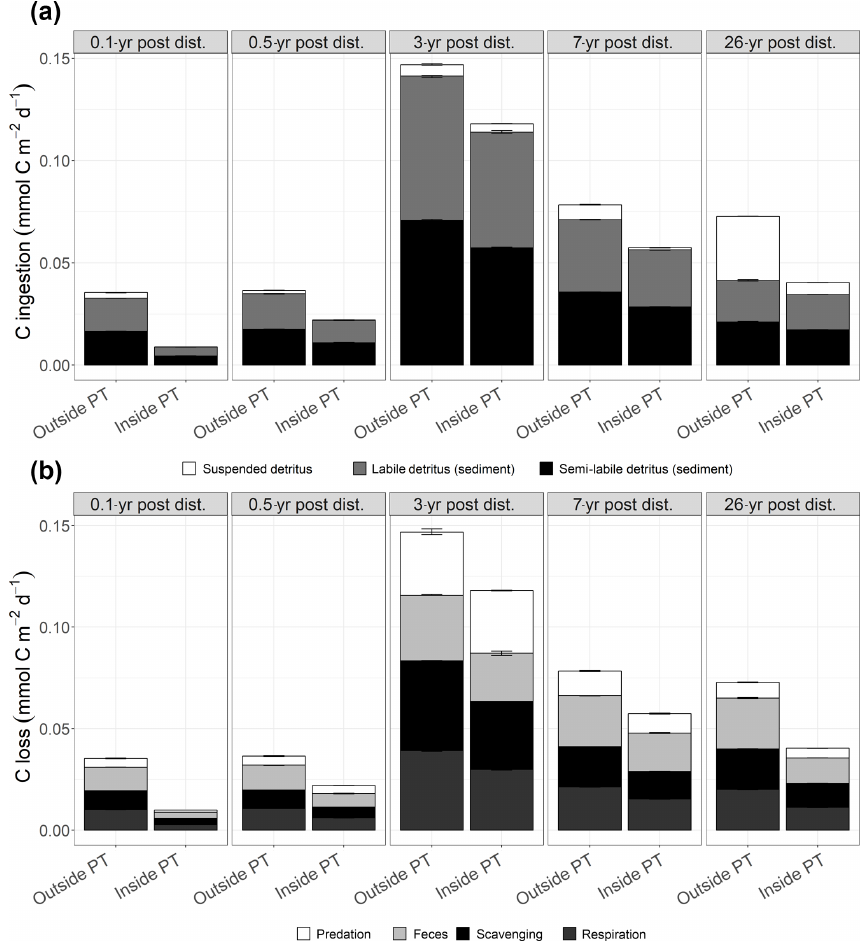
Figure 5. (a) Mean faunal carbon ingestion (mmolCm − 2 d − 1 ) as suspended detritus, sedimentary labile and sedimentary semi-labile detritus outside and inside plough tracks 0.1-year post-disturbance (PD 0 . 1 ), 0.5-year post-disturbance (PD 0 . 5 ), 3-year post-disturbance (PD 3 ), 7-year post-disturbance (PD 7 ), and 26-year post-disturbance events (PD 26 ). (b) Mean carbon losses (mmolCm − 2 d − 1 ) from the food webs as predation, feces, scavenging on the carcass, and faunal respiration outside and inside plough tracks during PD 0 . 1 , PD 0 . 5 , PD 3 , PD 7 , and PD 26 . In both figures, the error bars represent 1 standard